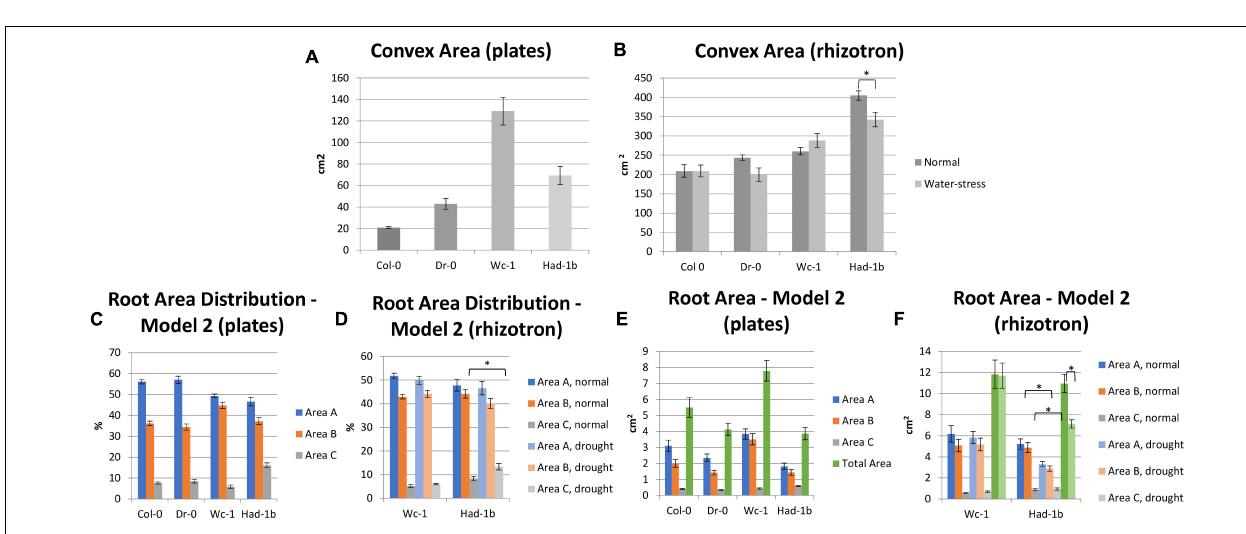
FIGURE 6 | Shoot trait measurements for rhizosheet experiments, for four accessions. (A–E) Results of shoot measurements. (F) Visualization of shoots of two accessions on 24 DAG in a rhizosheet. *, p < 0.05 as analyzed by a Student’s t -test.